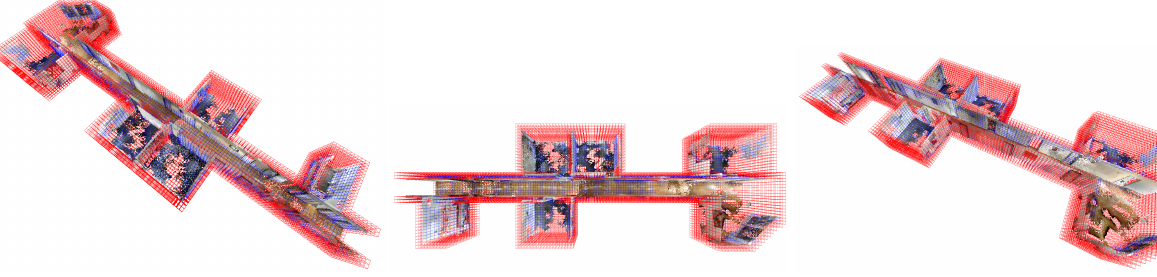
Figure 4. Experimental visualization results for the binary deviation analysis, with detected deviating points colored in red.